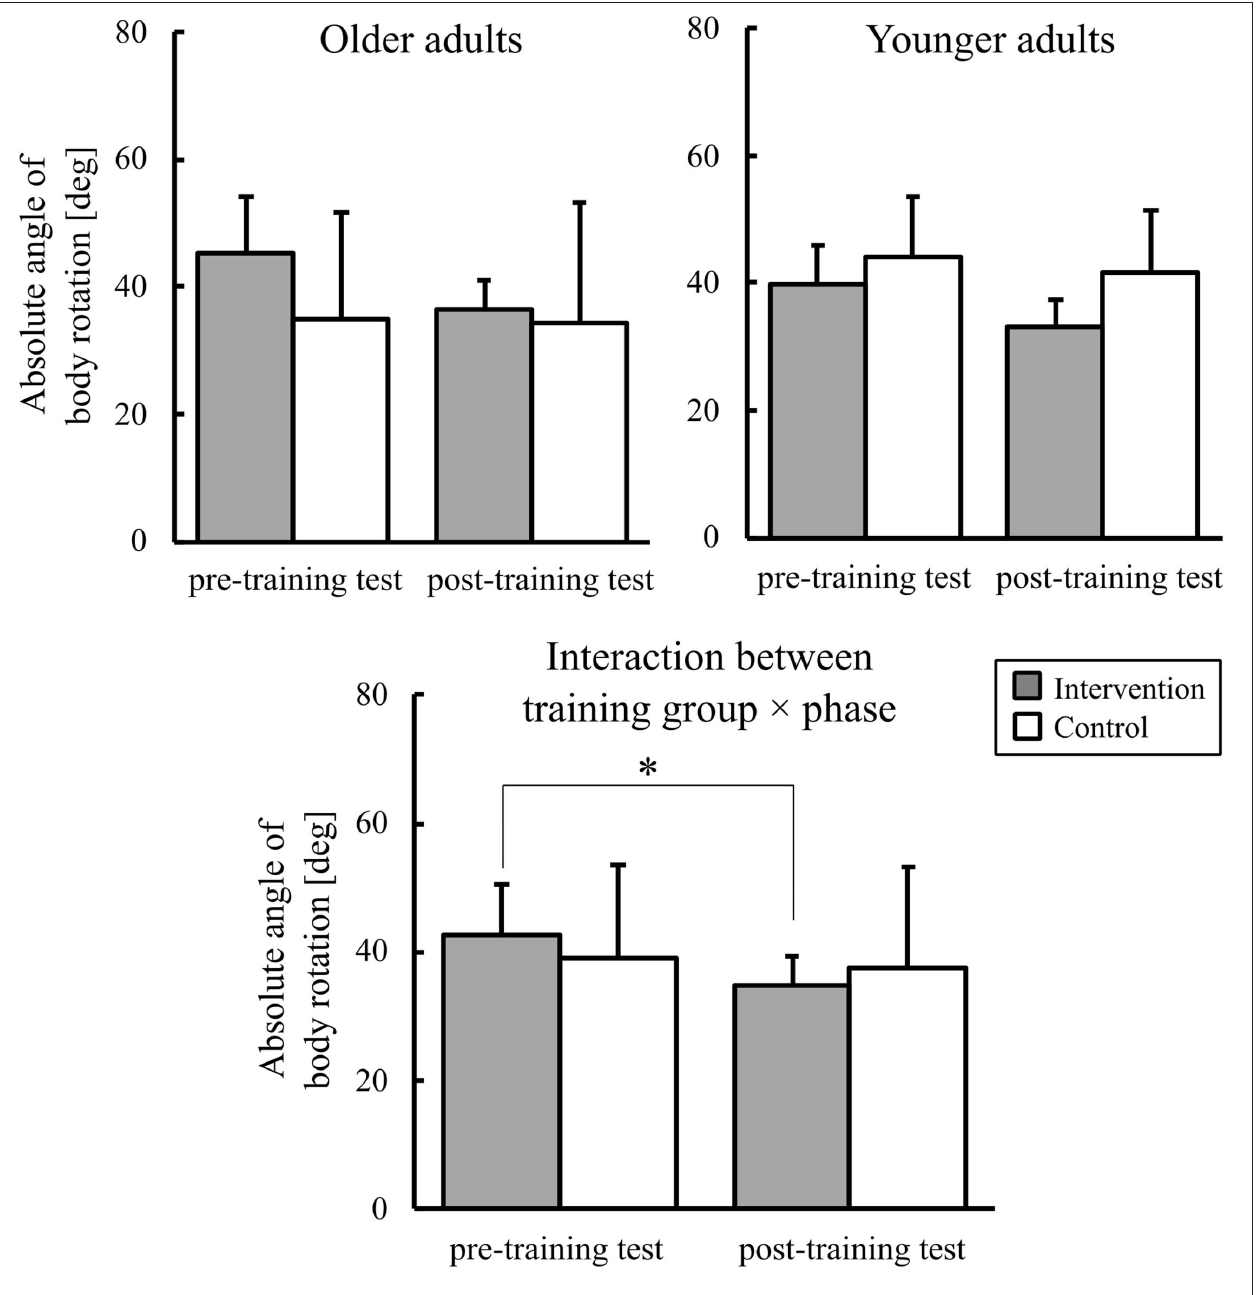
FIGURE 7 | Graphs of the mean absolute angle of body rotation. Error bars represent the standard deviation among participants. * indicates the significant